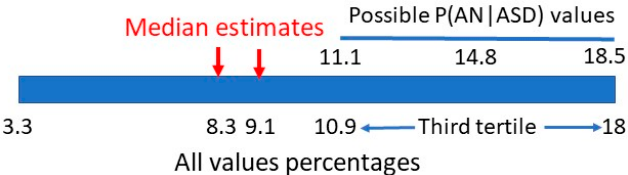
Figure 16. Bayesian matrix range of